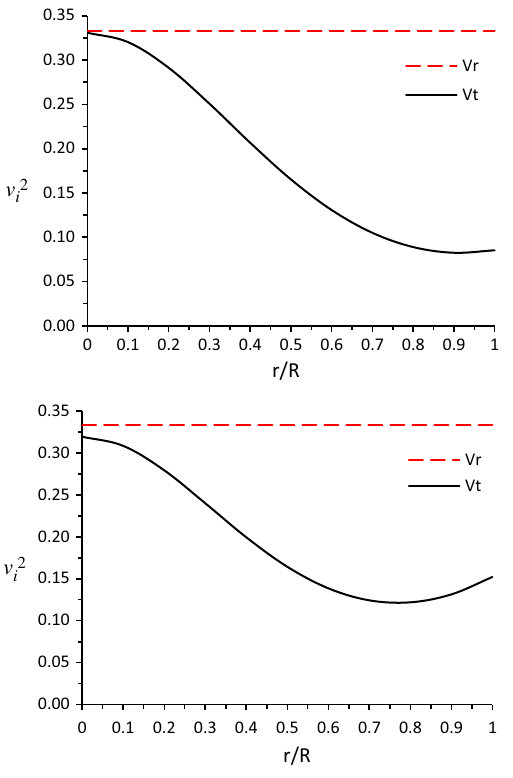
Fig. 5 Behavior of energy conditions versus radial coordinates r / R . For plotting of this figure, the corresponding values of arbitrary con- stants or parameters are displayed in Table 1